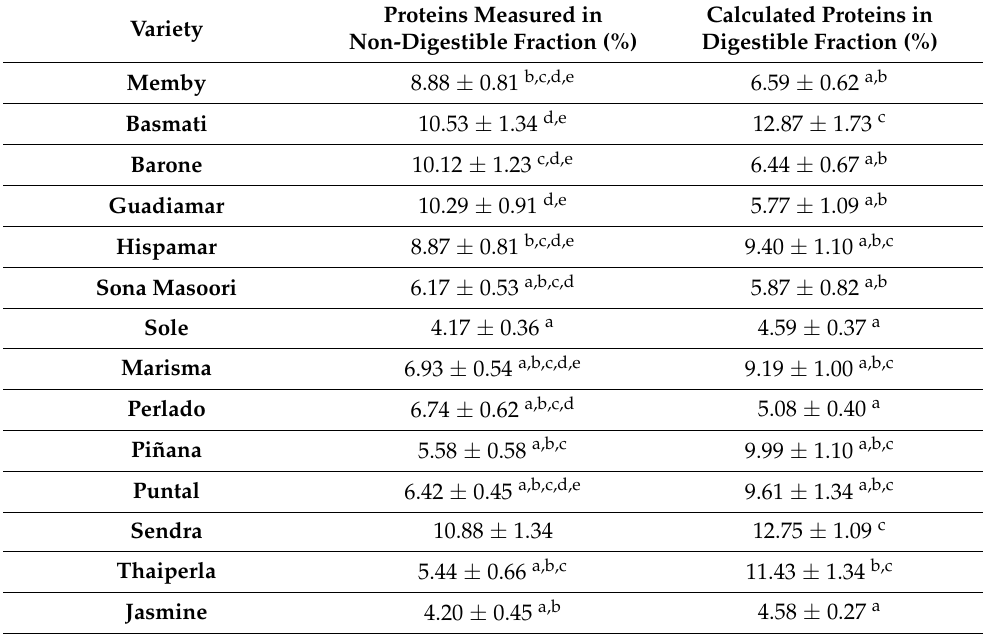
Table 8. Percentage of protein in non-digestible and digestible fraction. Proteins Measured in Variety